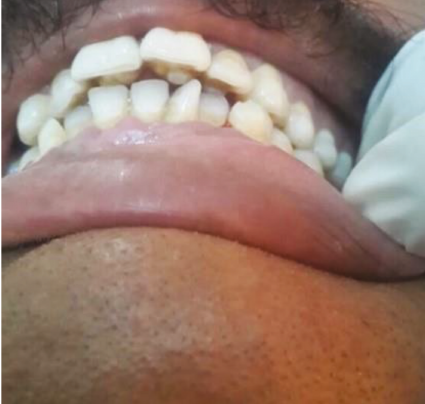
Figure 20: Case 4: periapical view for central incisors.